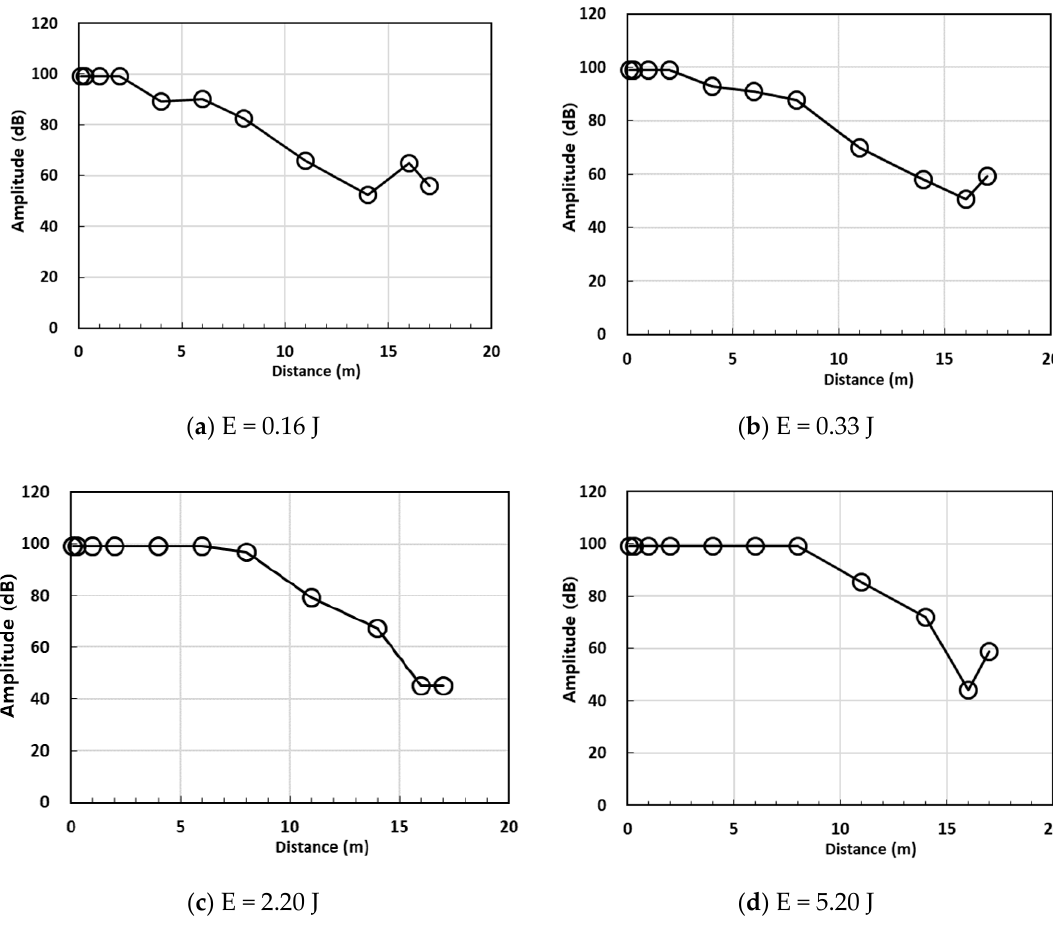
Figure 14. Amplitude according to distance.